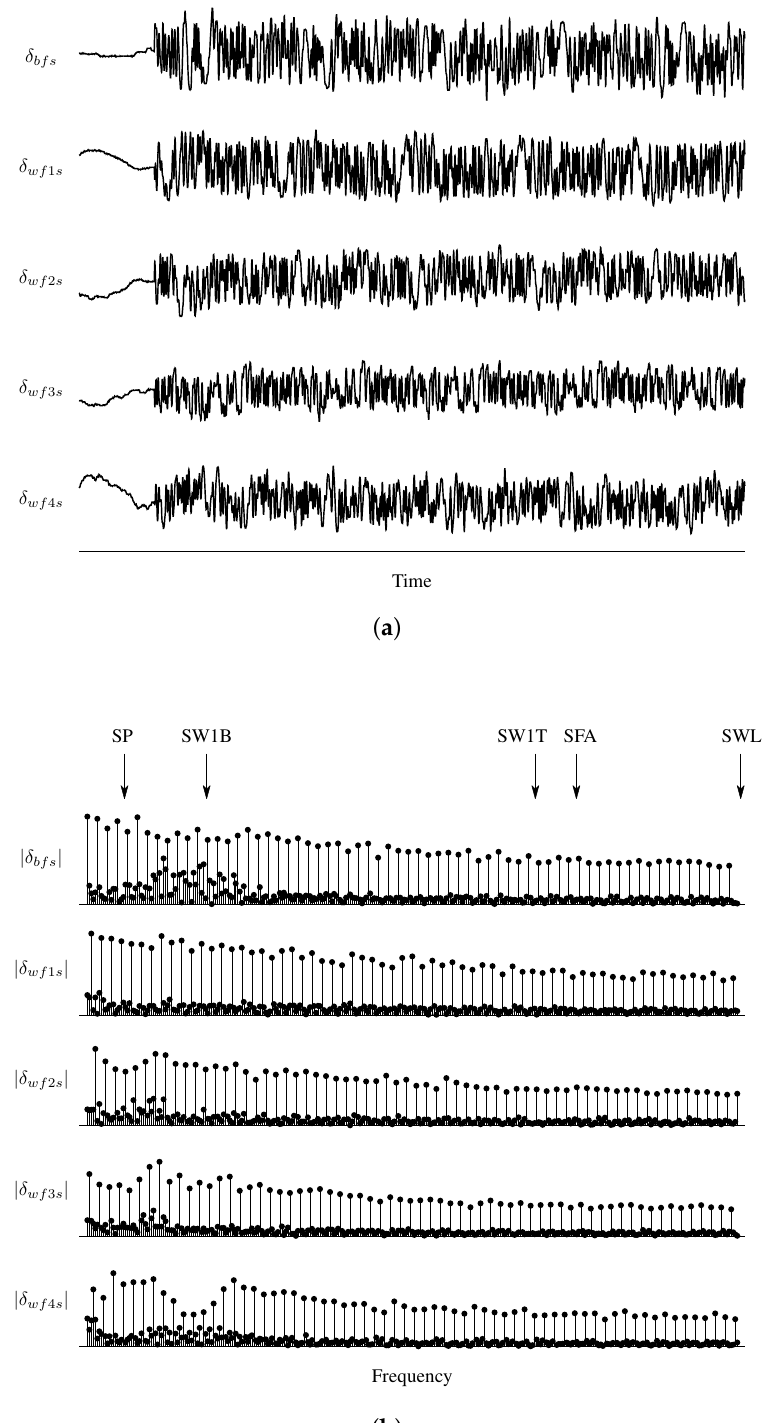
Figure 3. Control surface deflections (Flight 18, FTA 506, 32% fuel, 80% flutter speed): ( a ) measured time histories; and ( b ) Fourier transform amplitude spectra with approximate modal frequencies